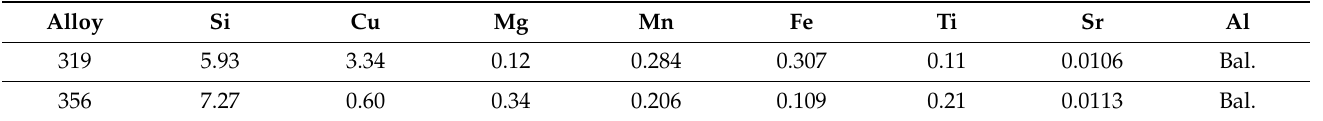
Table 1. Chemical compositions of the alloys studied (wt.%).